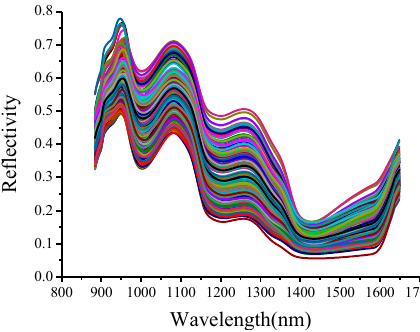
Figure 3. Average reflectance spectra of the 300 Nanguo pear samples.